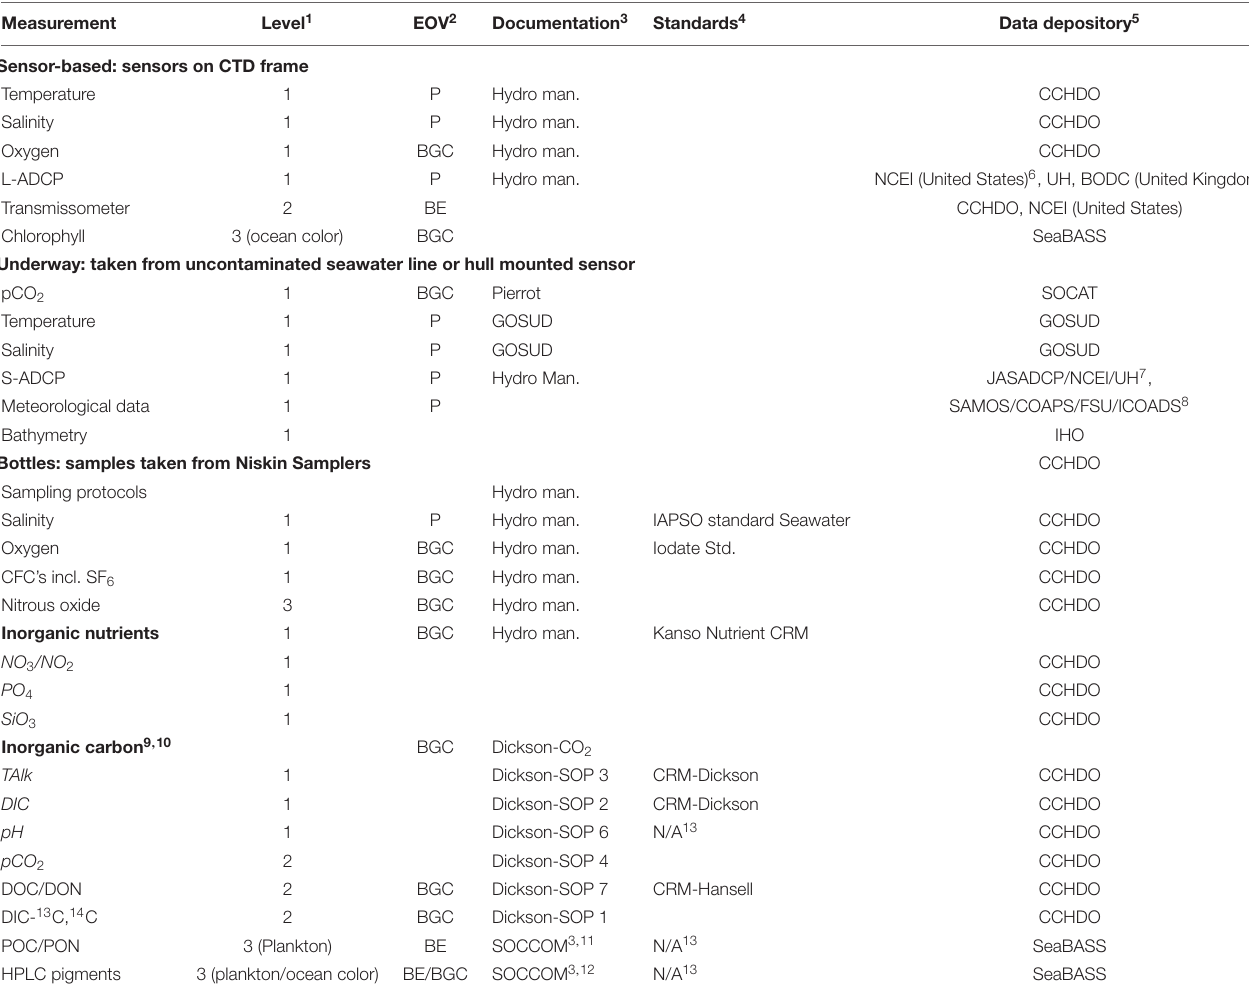
TABLE 2 | Variables measured on Global Ocean Ship-Based Hydrographic Investigations Program (GO-SHIP) cruises 1 with location of documentation, calibration, and data storage.